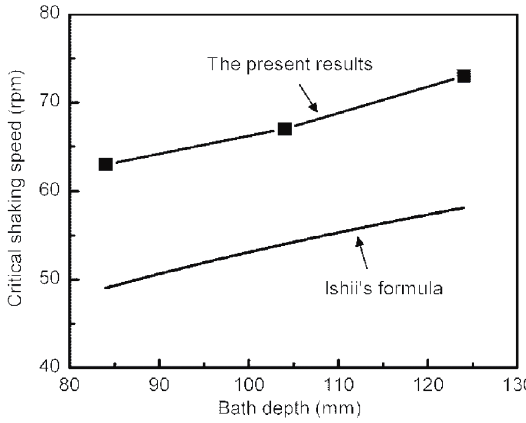
Fig. 9: Comparison of CSS-MT obtained from present authors and previous investigators